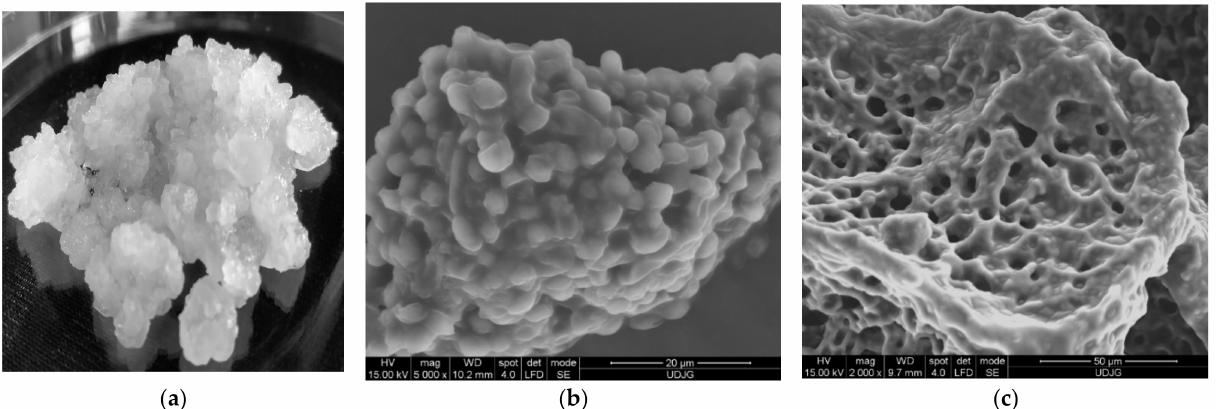
Figure 2. Water kefir grains ( a ) and Scanning Electron Microscopy (SEM) micrographs of water kefir grains at the surface at × 5000 magnification ( b ), at the surface at × 2000 magnification ( c